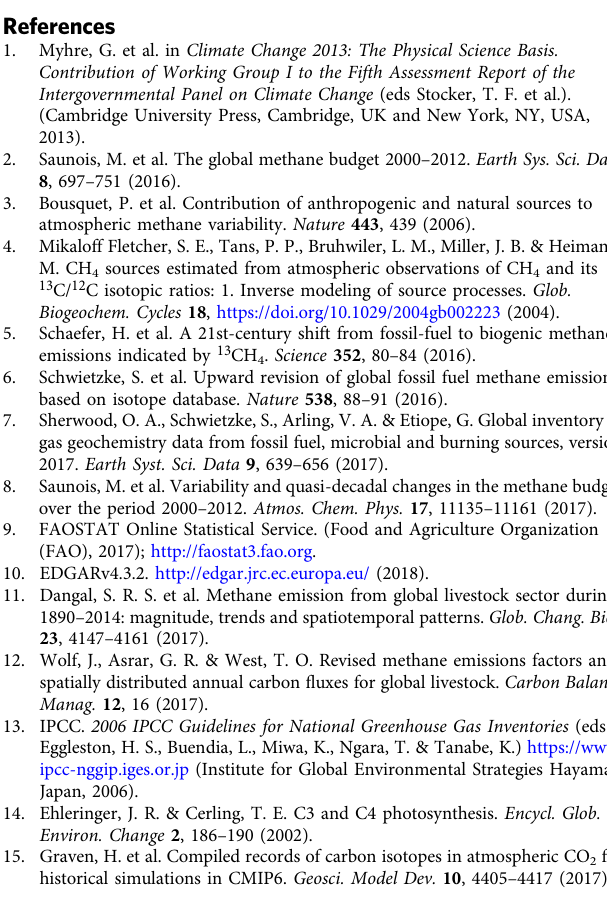
Supplementary Table 2. The source data underlying Figs. 4 and 5 can be found in the IIASA DARE